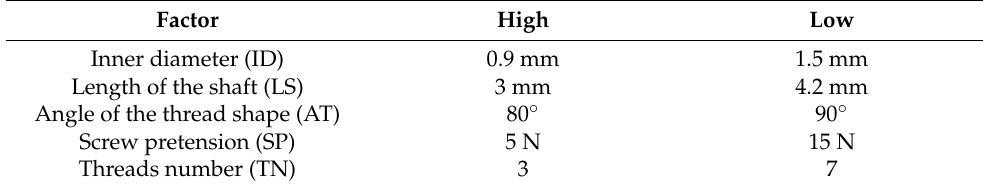
Table 1. Factors and levels for design of experiments (DOE) arrangement.